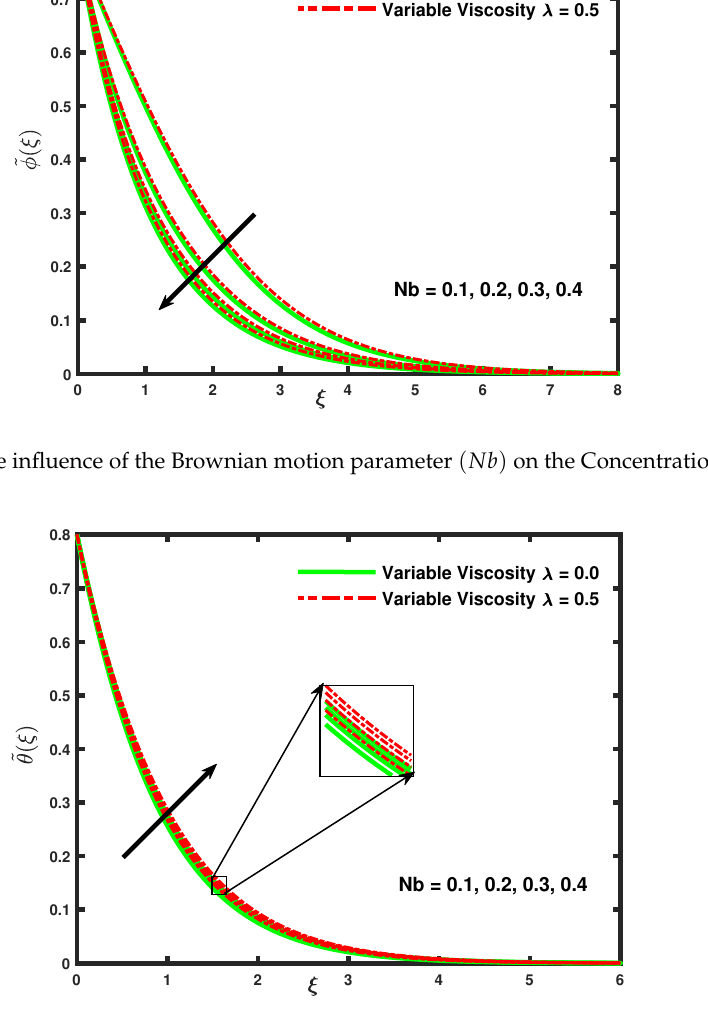
Figure 9. The influence of the Brownian motion parameter ( Nb ) on the Temperature